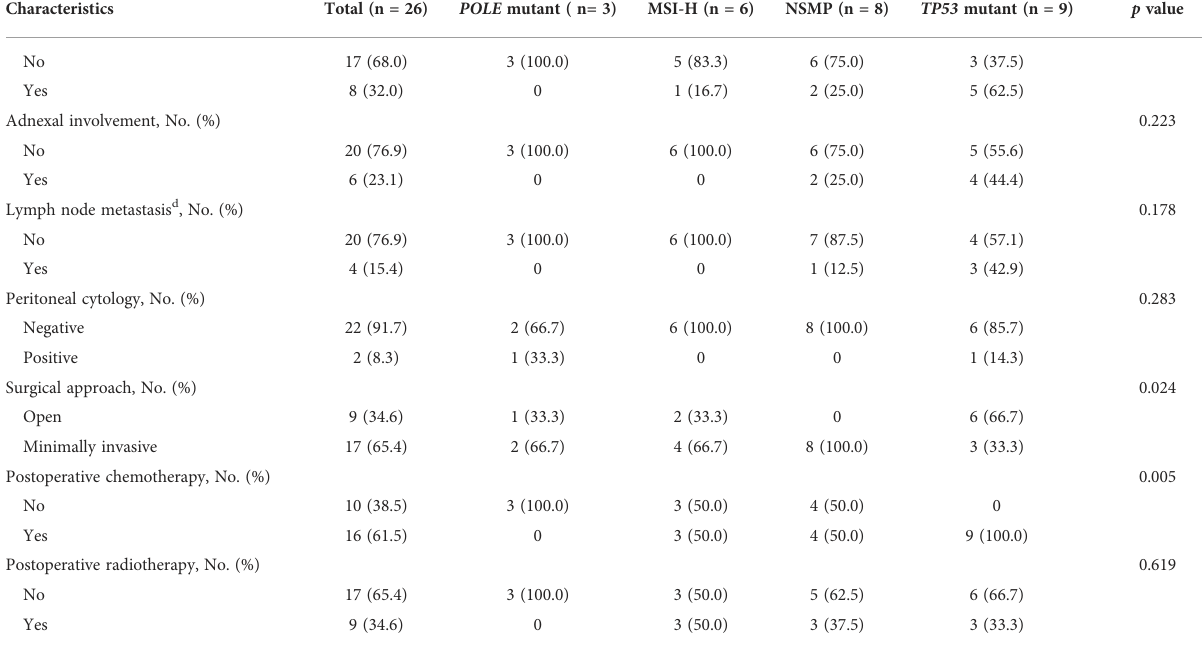
We examined tumor-in fi ltrating immune cells in the three molecular subtypes using multiplex immuno fl uorescence assays (Figure 3 and Figure S2). The fractions of CD8 + T cells in both the tumor parenchyma and the tumor mesenchyme were higher in the TMB-H and TP53 mutant subtypes than in the NSMP subtype, although the differences were not statistically signi fi cant ( p = 0.094 for tumor parenchyma, p = 0.215 for tumor mesenchyme). The in fi ltration of M1 macrophages and CD56 dim NK cells did not differ signi fi cantly among the three subtypes. (Figure 4 and Table S2) With regard to negatively regulatory immune cells, a trend of a higher degree of in fi ltration of M2 macrophages was observed in tumors of the TP53 mutant subtype comparing with tumors of the other two subtypes (Figures 5A, B). Similar trends were also observed in the ratios of M2 macrophage fractions to M1 macrophage fractions (Figures 5C, D). The percentage of T reg cells and the ratio of T reg cell fractions to CD8 + T cell fractions in the tumor parenchyma were the highest in the TP53 mutant subtype among the three molecular subtypes, but the differences were not signi fi cant. Interestingly, we noticed that the fraction